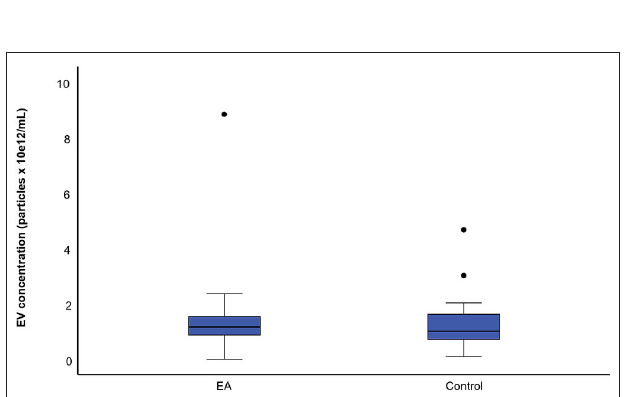
FIGURE 5 | Boxplots of mean particle concentration for the asthmatic (EA) ( n = 35) and control horses ( n = 19). The samples were analyzed by nanoparticle tracking analysis. Each box represents the interquartile range. The horizontal line in the box represents the median, the whiskers the range, and the circles the outliers. There was no significant difference between the